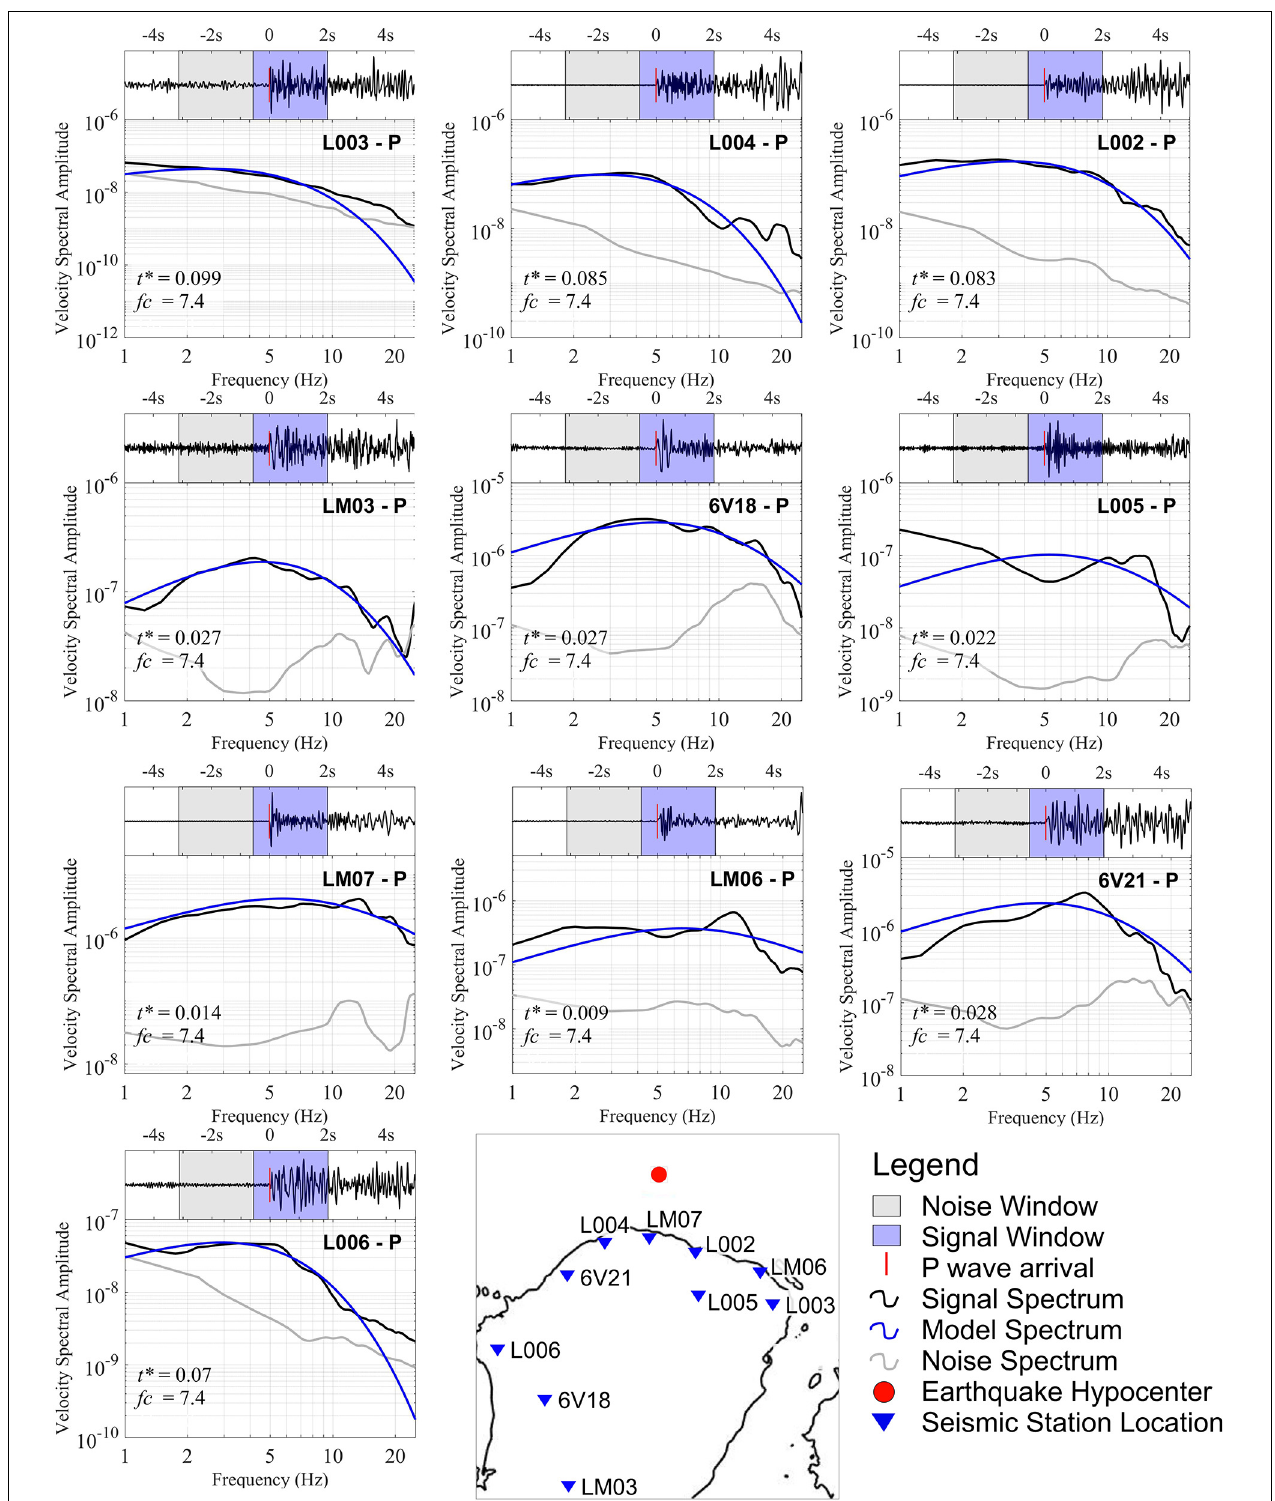
FIGURE 2 | Example of spectral amplitude fitting of one earthquake in ten stations (location is shown by inset map). For each plot, we show the normalized time-series waveform data of the vertical component (top panel) and the signal and noise spectra (bottom panel). The window used in the analysis is 2.56 s (0.56 s before the arrival time and 2 s after the arrival time). The signal used in the study is within the blue-shaded windows, and the noise is within the gray-shaded windows. The gray line is the noise spectrum, the black line is the signal spectrum, and the blue line is the model (calculated) spectrum.